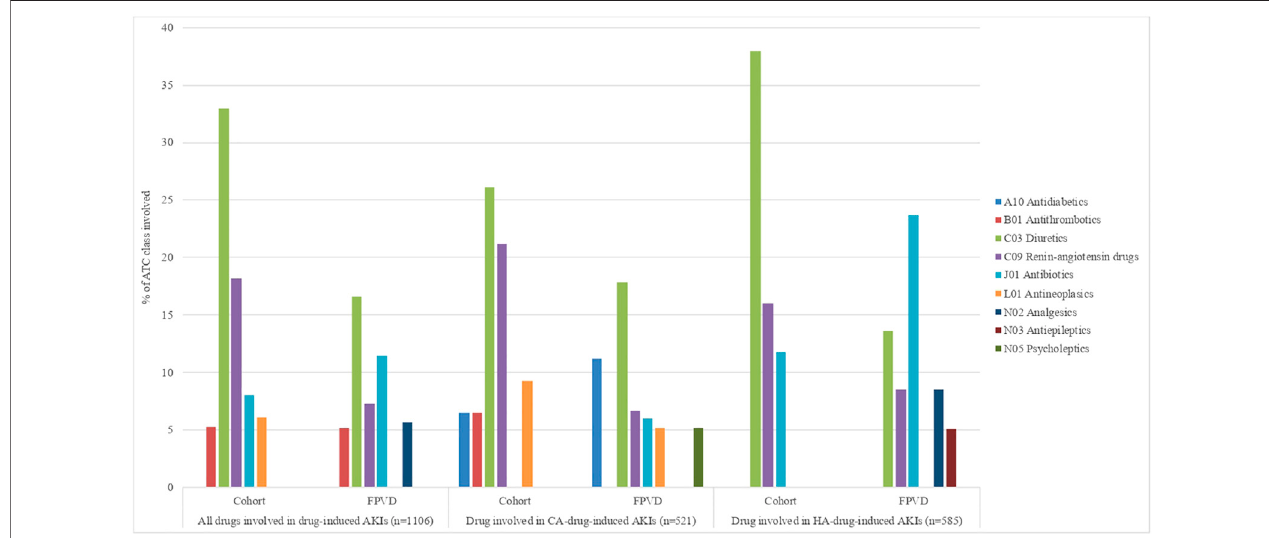
FIGURE 3 | Drug-induced AKIs, according to the ATC classi fi cation level 2 drugs involved in more than 5% of cases. AKI, acute kidney injury; CA, community- acquired; FPVD, French national pharmacovigilance database; HA, hospital-acquired.